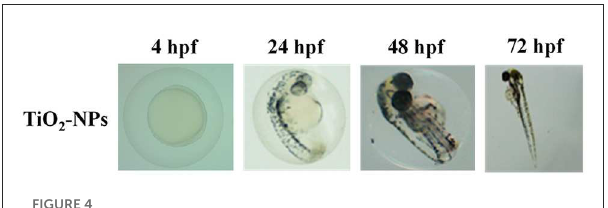
FIGURE4 Effects of TiO 2 -NPs on the phenotypes of both embryos and larvae at different (4, 24, 48, and 72)